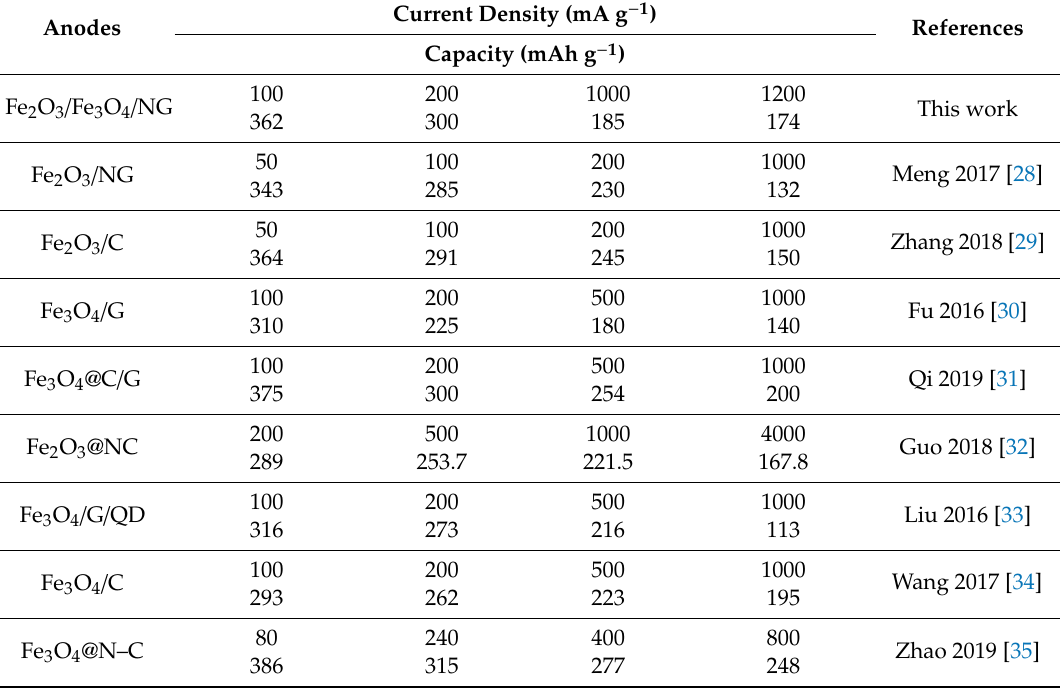
Scheme 2. Schematics of structures, electron transfer and transport, and ion di ff usion in Fe 2 O 3 / NG (upper) and Fe 2 O 3 / Fe 3 O 4 / NG (lower) composites. Table 2. Comparison of the specific capacities of iron oxide based anodes in literature and Fe 2 O 3 / Fe 3 O 4 / NG anode in this work.